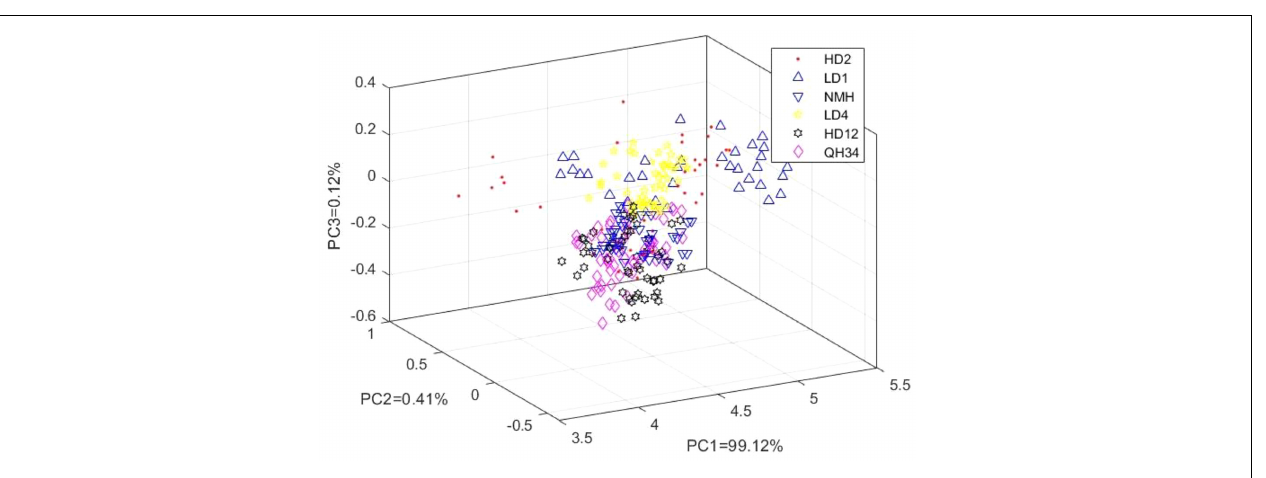
FIGURE 3 | The PC score